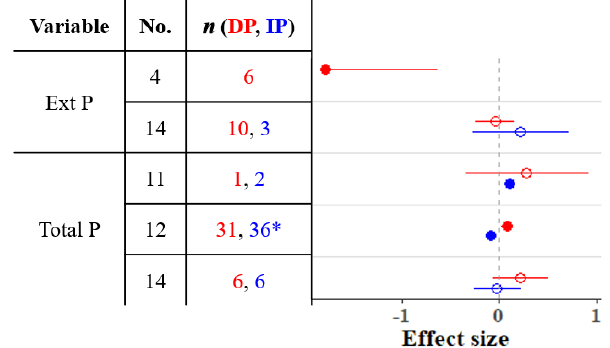
Figure 4. Effect sizes for soil phosphorus variables responding to decreased (red) and increased (blue) precipitation. Filled points rep- resent a significant effect size (95% CI not overlapping 0), and open points represent a nonsignificant effect size. Variable names corre- spond to Table 2. No. is meta-analysis number as listed in Tables 1 and 2. The sample size is indicated by n . Asterisks indicate missing 95%